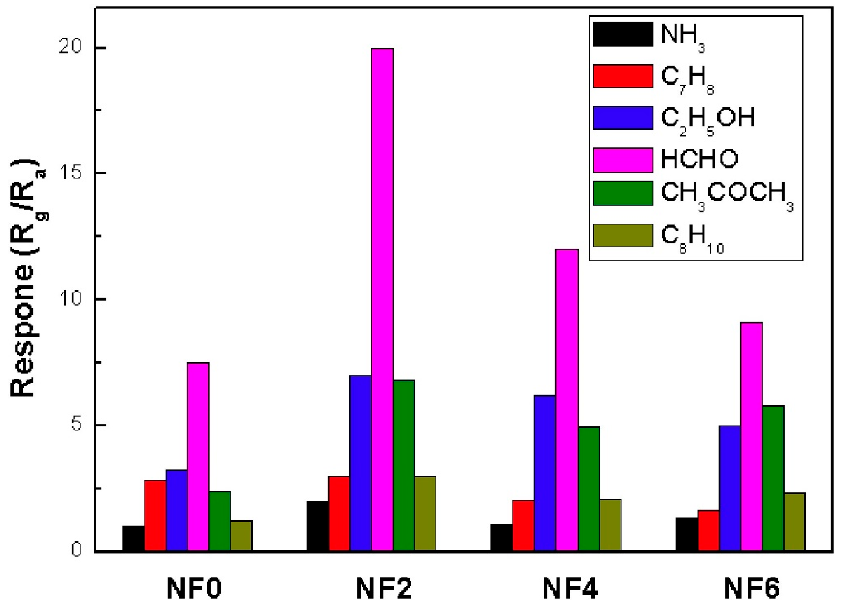
Figure 5. Responses of the sensors to 100 ppm different gases at their optimum working temperature; LaFeO 3 nanofibers doped by different amounts of Ag were marked as NF0, NF2, NF4 and NF6 (reproduced with the permission from reference [104]).